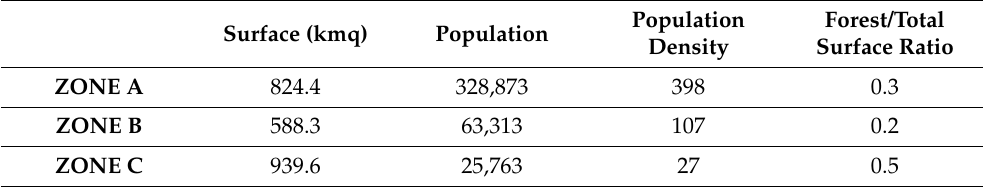
Table 1. Data relating to area extension, number of inhabitants, population density, and forest extension (expressed as its relationship with the total area surface) for each